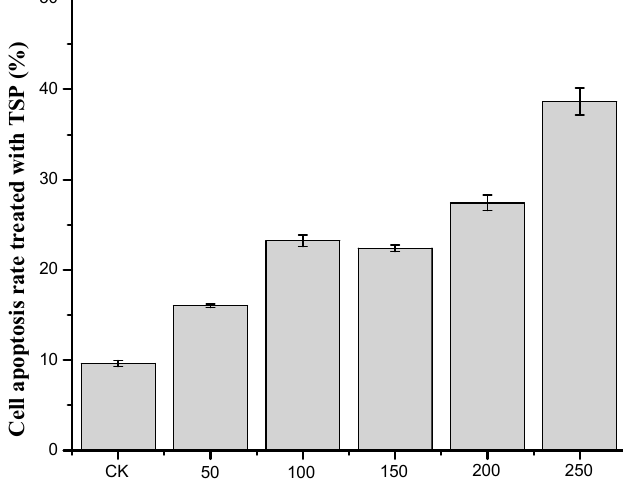
Figure 4. The apoptosis rate of cells treated with different concentrations of TSP.